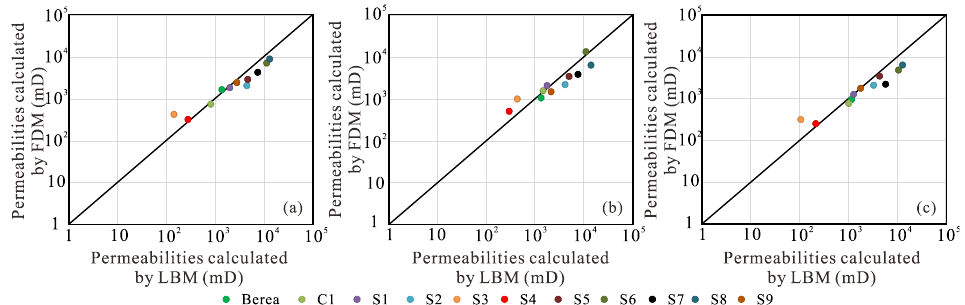
Figure 19. Comparison between the permeabilities calculated by LBM [50] and IFDM for digital rock images at their original size. ( a ) Permeabilities calculated in macroscopic flow direction of x ; ( b ) Permeabilities calculated in macroscopic flow direction of y ; ( c ) Permeabilities calculated in macroscopic flow direction of z .